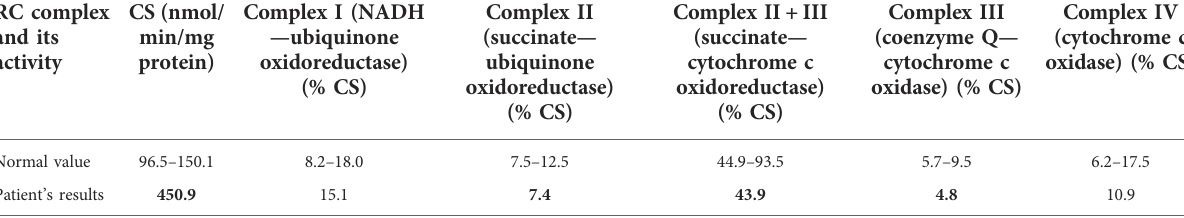
RC, respiratory chain; CS, citrate synthase. Bold values indicate abnormal results.